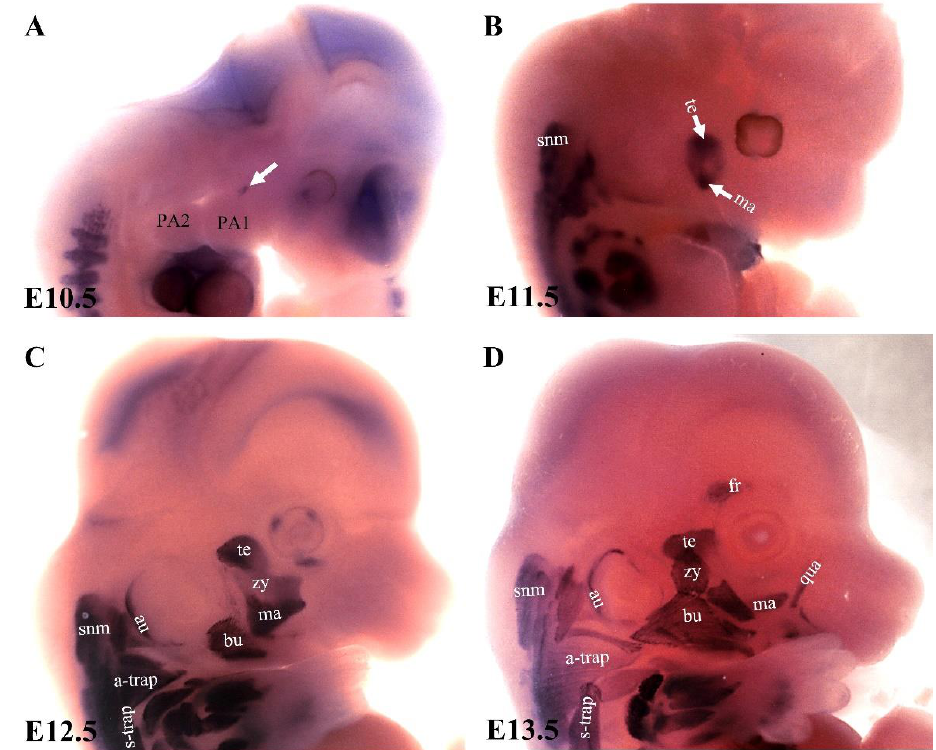
Figure 5. The emergence of myosin heavy chain during the development of the mouse branchiomeric muscle. ( A – D ) Analysis of myosin heavy chain (MyHC) expression using whole-mount in situ hybridization. Lateral views of E10.5, E11.5, E12.5, and E13.5 mouse embryos. The MyHC transcripts emerged in the first arch-derived muscle anlagen (white arrow in ( A )) before the second and caudal brachial-derived muscle anlagen. Note: a-trap, acromiotrapezius; au, auricularis; bu; buccinator; fr, frontalis; ma, masseter; PA1, first pharyngeal arch; PA2, second pharyngeal arch; qu, quadratus labii; snm, somitic neck muscle; s-trap, spinotrapezius; te, temporalis, zy, zygomaticus.